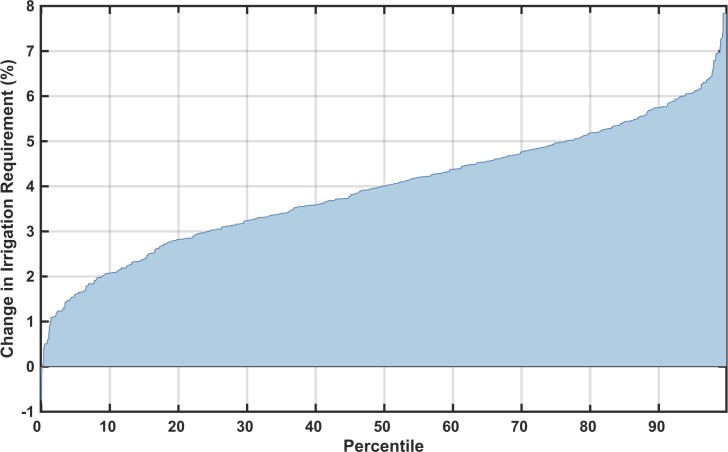
As in Fig 9, but shown for percentage change in irrigation requirement across all ensemble members.Each point in the line represents one of 551 climate scenarios.